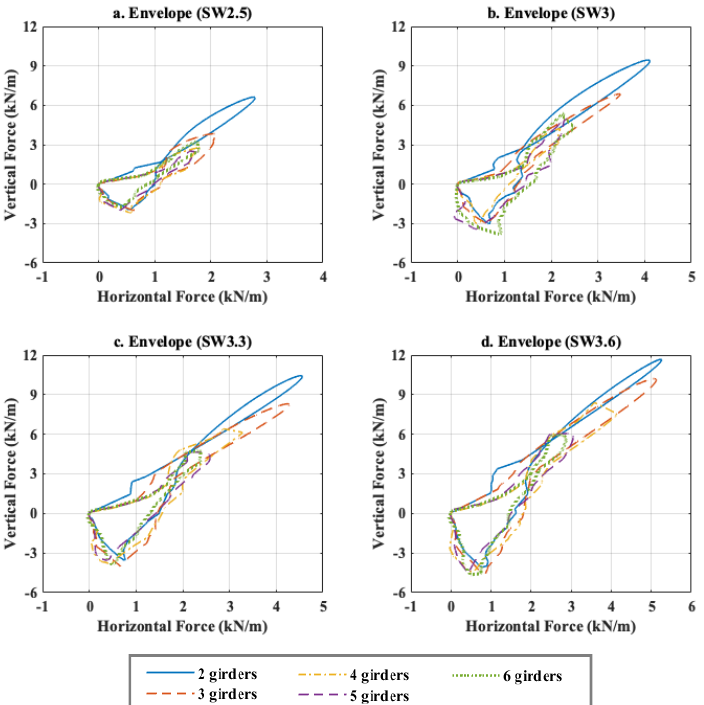
Figure 11. Envelopes of horizontal and vertical forces applied on decks with different number of girders ( Ng = 2, 3, 4, 5, 6) by four selected wave heights.